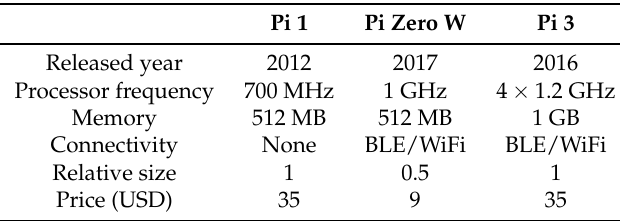
Table 2. The Raspberry Pi platform over